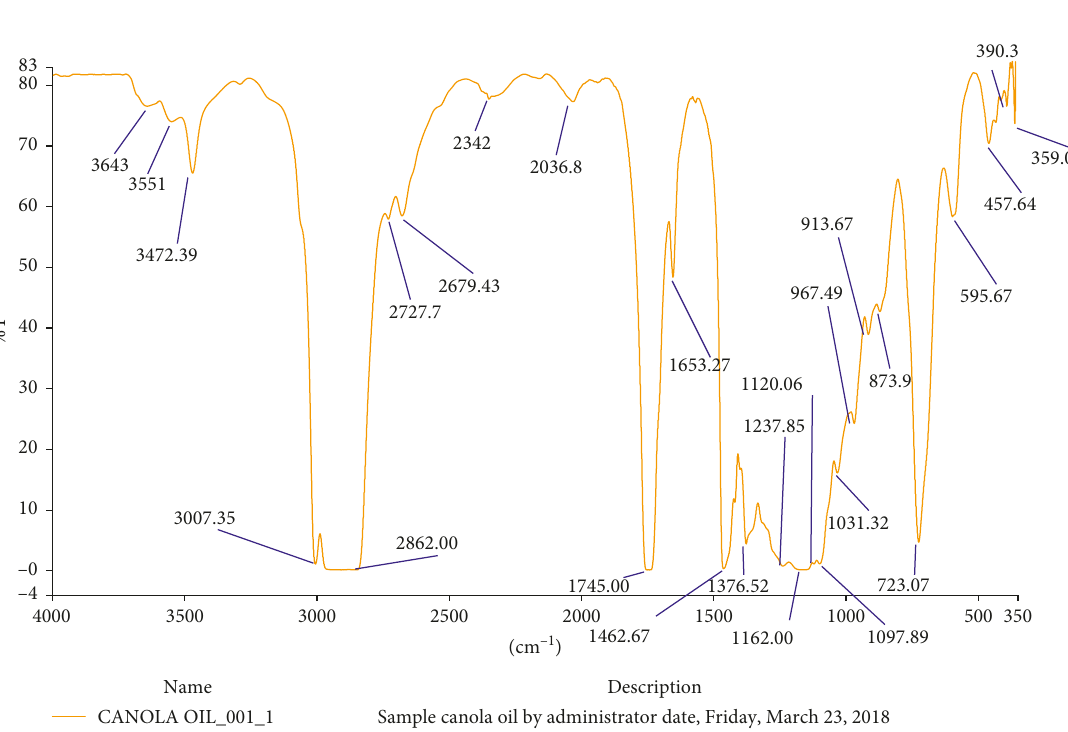
Figure 6: SHBF FTIR spectra.